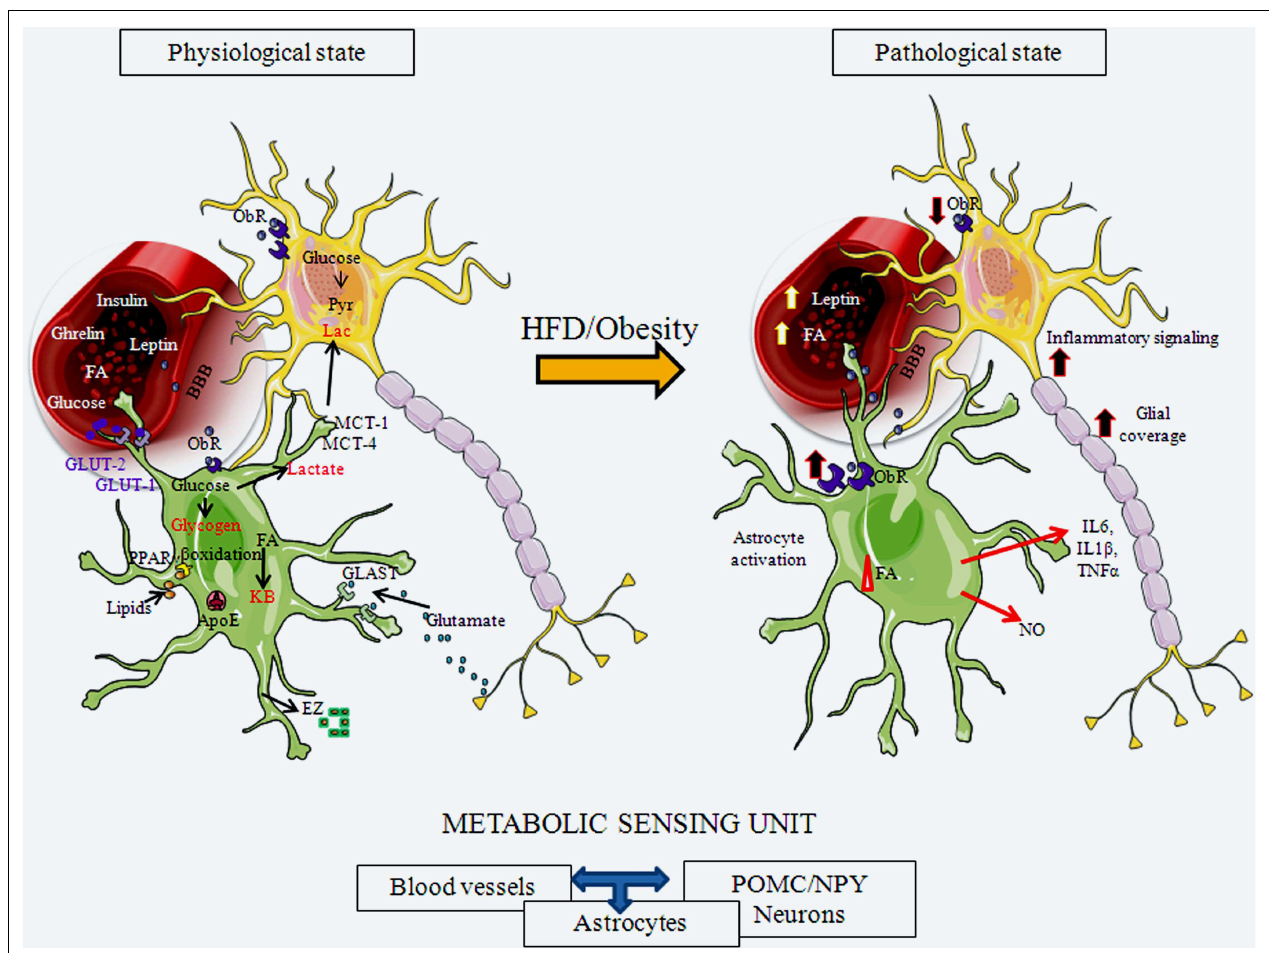
increasing their projection number and size and, increasing the glial coverage of both POMC and NPY neurons, as well as their contact with local blood vessels.This results in modifications in synaptic inputs to these neurons and possible changes in transport of substances from